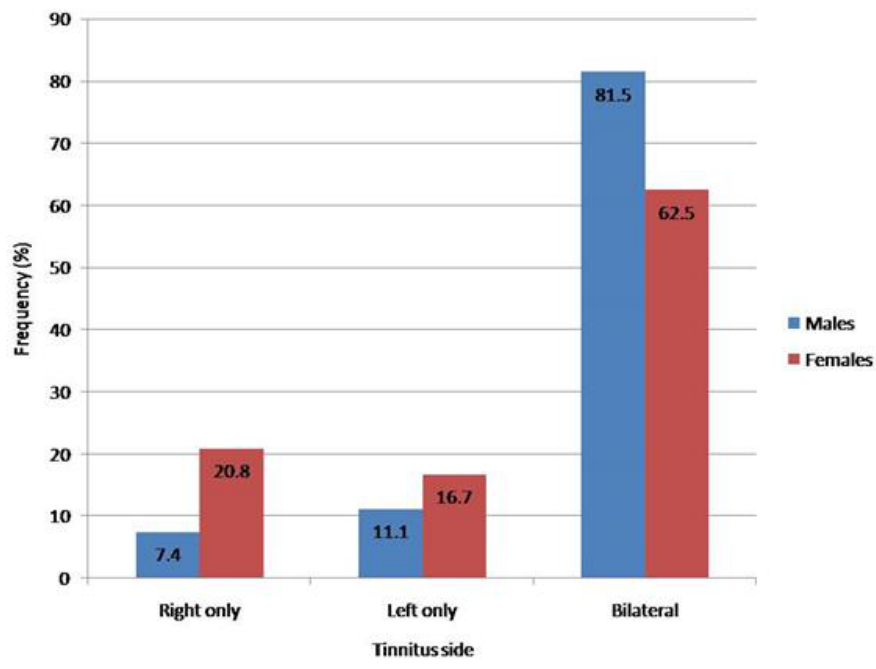
Figure 2. Frequency of tinnitus appearance by its side, in males (blue) and females (red).